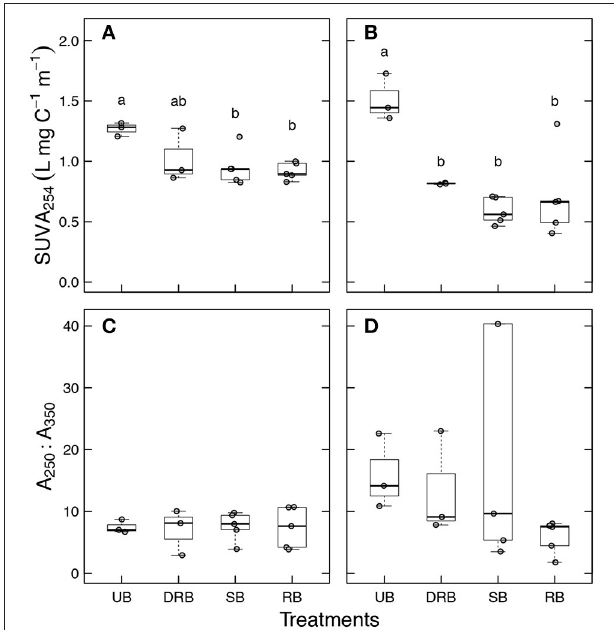
FIGURE 3 | SUVA254 (top row) and A 250 :A 365 (bottom row) in the soil leachate from unburned (UB), dry rapidly burned (DRB), slowly burned (SB), and rapidly burned (RB) soil aggregates from (A,C) forest soil and (B,D) shrubland soil. No significant differences A 250 :A 365 were found between burn treatments. Different letters represent significantly different means in SUVA254 as determined from Tukey’s HSD Test ( P < 0.05).